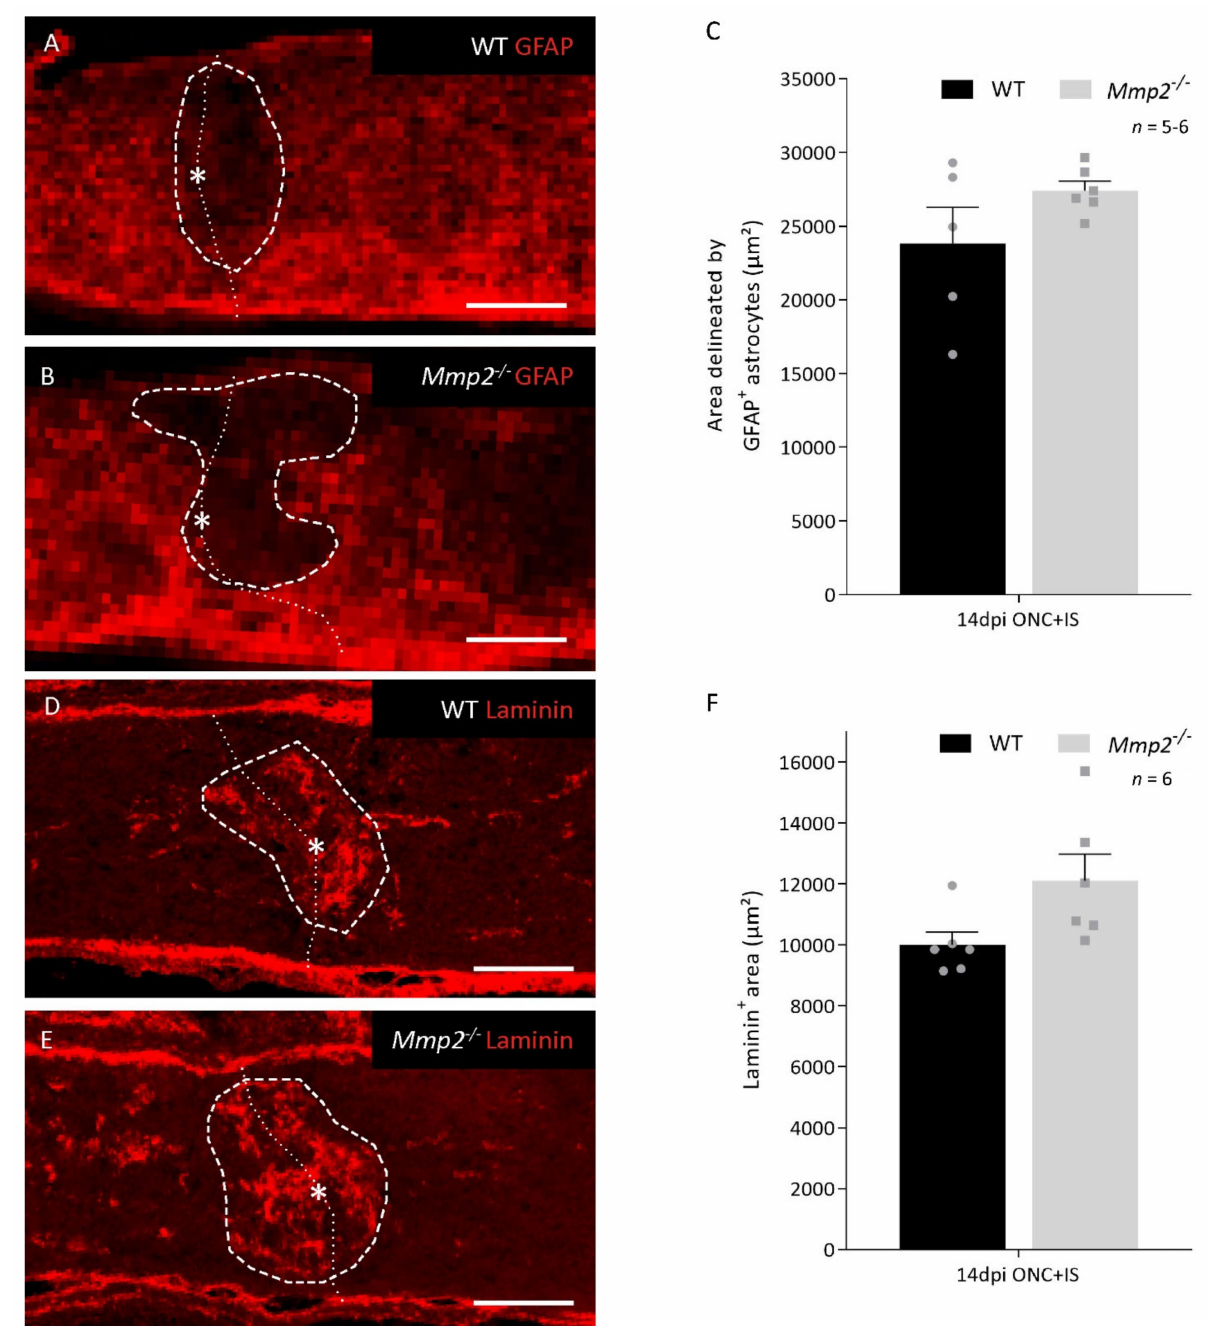
Figure 3. Glial scar formation in WT and Mmp2 -/- mice at the optic nerve injury at 14 dpi ONC+IS. ( A , B ) Images showing a GFAP immunostaining at the ONC site for WT ( A ) and Mmp2 -/- ( B ) mice at 14 dpi ONC+IS. The ONC site is indicated with an asterisk and a dotted line and the measured area is indicated with a dashed line. Scale bar: 100 µ m. ( C ) Graphic of the quantification of the glial scar size measured as the area delineated by GFAP + astrocytes at the ONC site in WT (black) and Mmp2 -/- (grey) mice at 14 dpi ONC+IS. The area was normalized to the width of the optic nerve. ( D , E ) Images showing a Laminin immunostaining at the ONC site for WT ( D ) and Mmp2 -/- ( E ) mice at 14 dpi ONC+IS. The ONC site is indicated with an asterisk and a dotted line and the measured area is indicated with a dashed line. Scale bar: 100 µ m. ( F ) Graphic of the quantification of the glial scar size measured as the Laminin + area at the ONC site in WT (black) and Mmp2 -/- (grey) mice at 14 dpi ONC+IS. The area was normalized to the width of the optic nerve. Data are shown as mean ± SEM. Statistical significance was determined by Student’s t